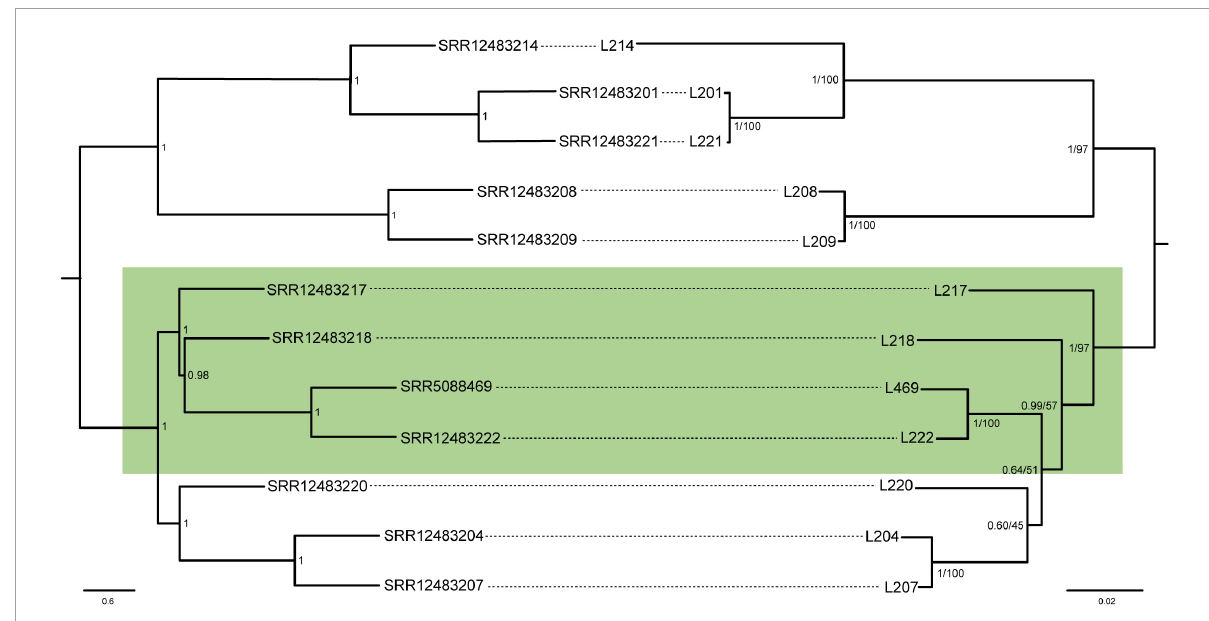
FIGURE2 Coevolutionary reconstruction comparing phylogenetic trees of the lice and Lightella neohaematopini. The host tree was inferred by ASTRAL-III method from 1,107 individual gene trees, each tree derived from one of the 1,107 nucleotide matrices by IQ-TREE using GTR + F + R10 model. The symbiont tree was inferred by MrBayes (BI under JTT + G + F model) and PhyML (ML under HIVb + G + F model) from the amino-acid five-gene “coevolutionary matrix” (1,150 aa). Lengths of the branches in the symbiont tree correspond to the BI results. Values at the nodes of the symbiont tree show posterior probabilities/bootstrap. Values at the nodes of the host tree show local posterior probabilities. The green box highlights the conflicting parts of the